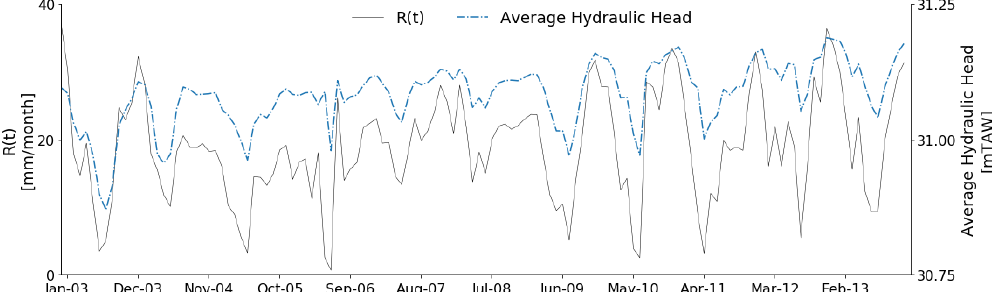
Figure 10. Average simulated groundwater head time series and groundwater recharge time